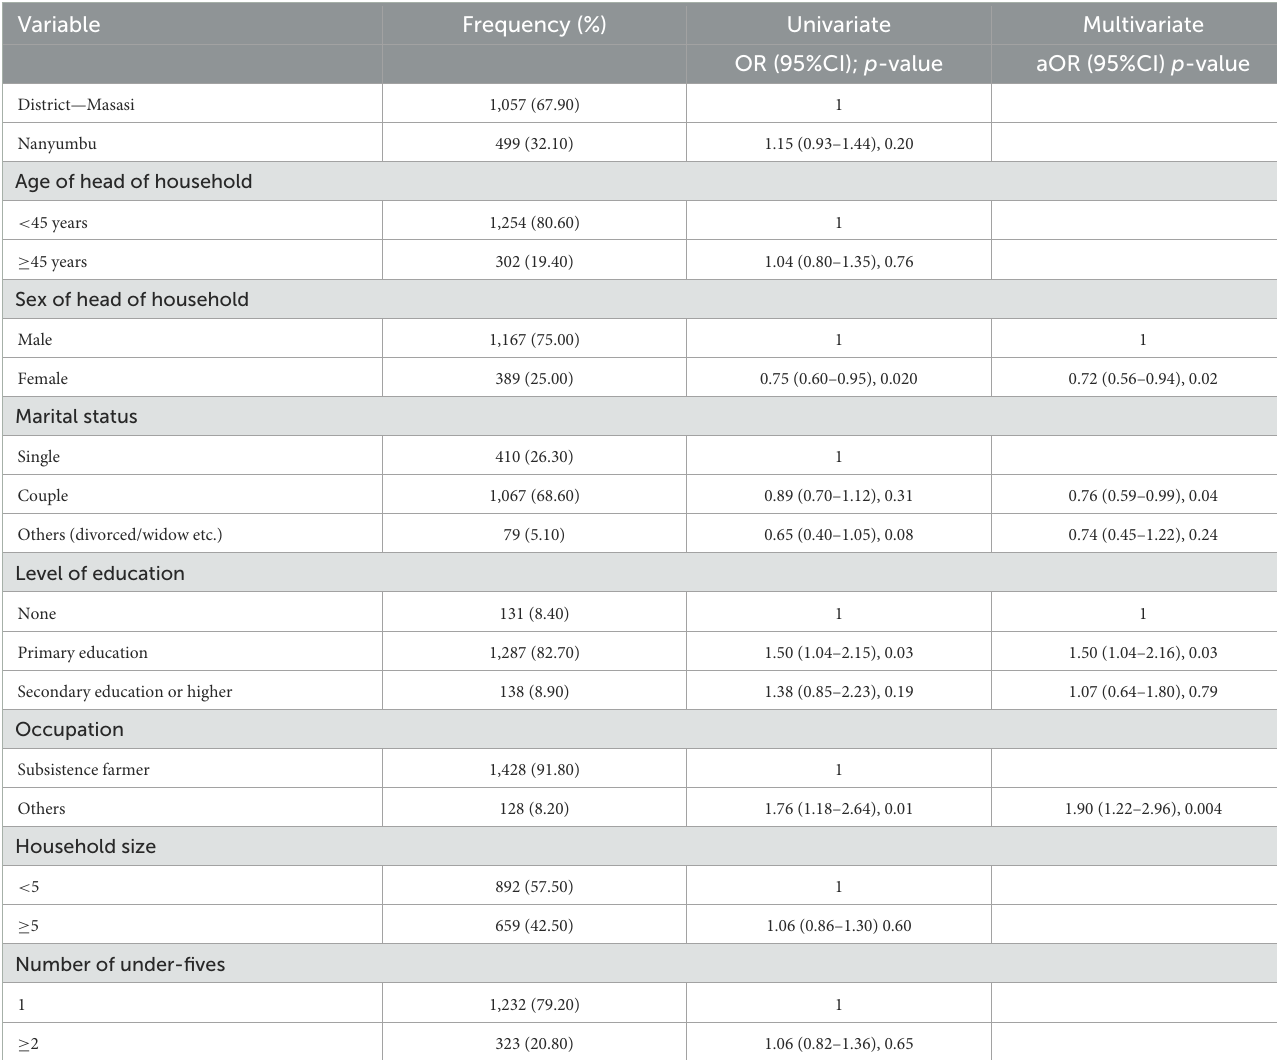
TABLE 3 Association of socioeconomic factors with knowledge of malaria infection.